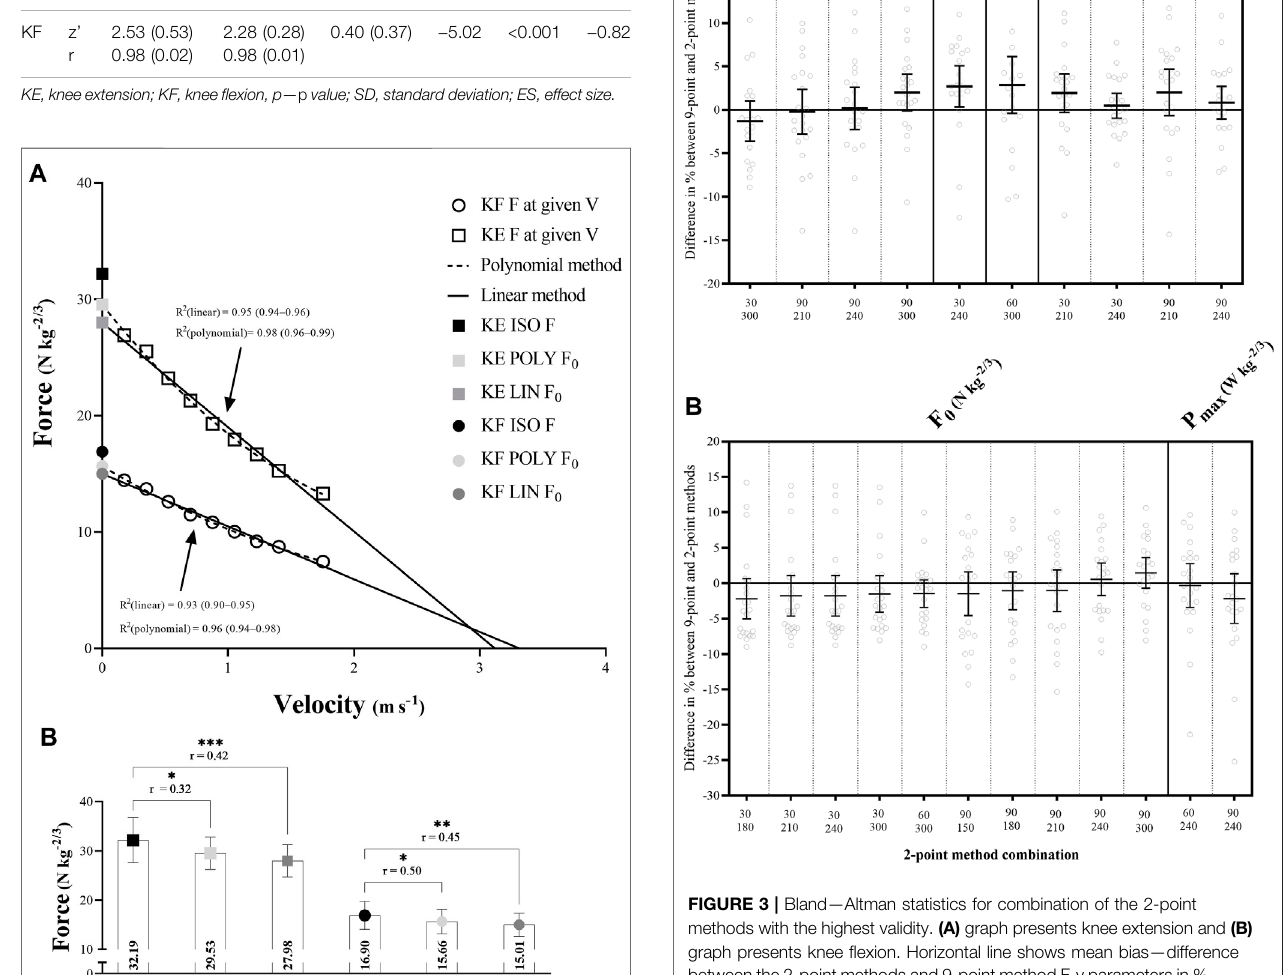
FIGURE 2 | (A) Polynomial and linear model with respective isometric force and (B) the differences between polynomial and linear maximal theoretical force and maximal isometric force. KF, knee fl exion; KE, knee extension; F, force; F 0 , maximal theoretical force; V, velocity; ISO, isometric; POLY, polynomial; LIN, linear; N, Newtons; kg, kilograms; m, meters; s, seconds. * p < 0.05, ** p < 0.01, *** p < 0.001.